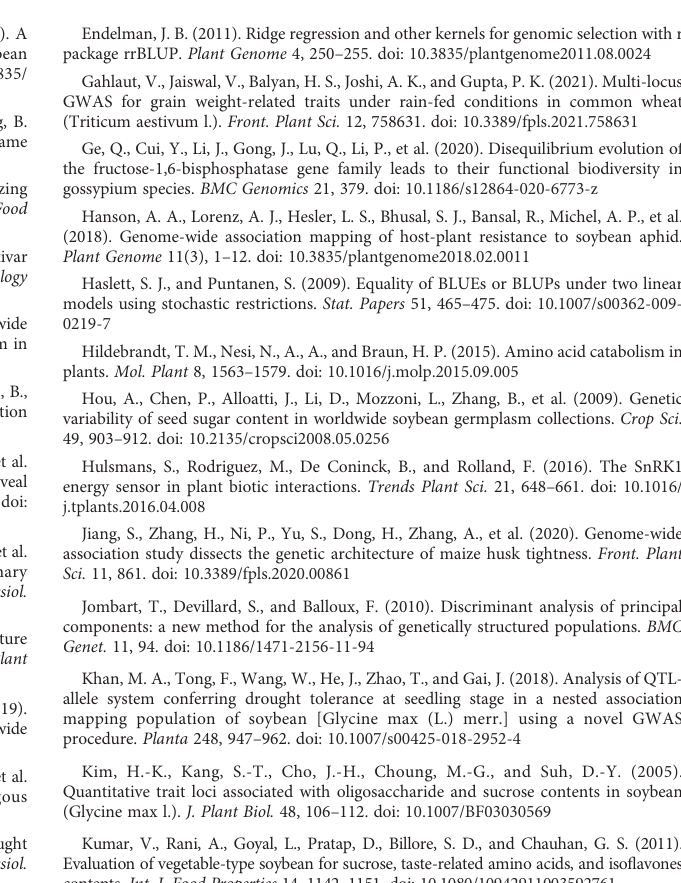
Germplasms utilized in present study and their populational